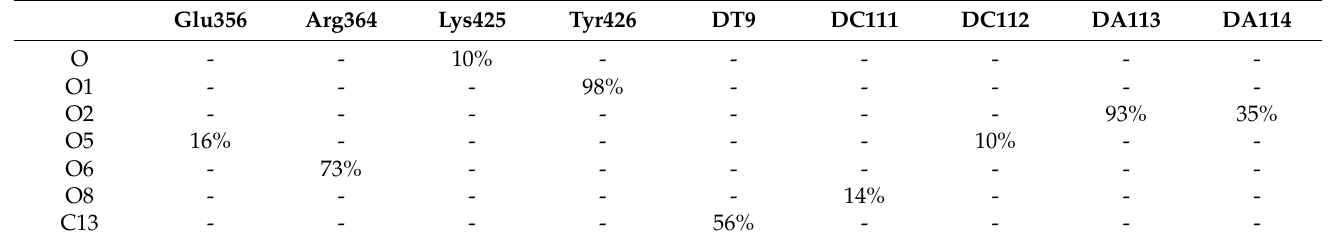
Table 4. Percentage of the permanence of most relevant non-covalent interactions between the atoms of the compound c7 and the amino acids or nucleotides of the receptor